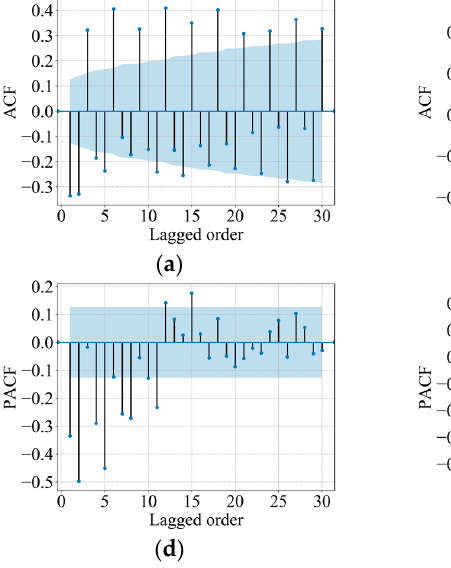
Figure 7. ACF and PACF plots of sample time series: ( a ) ACF plot of scratch defect; ( b ) ACF plot of micropore defect; ( c ) ACF plot of floating electrode defect; ( d ) PACF plot of scratch defect; ( e ) PACF plot of micropore defect; ( f ) PACF plot of floating electrode defect.